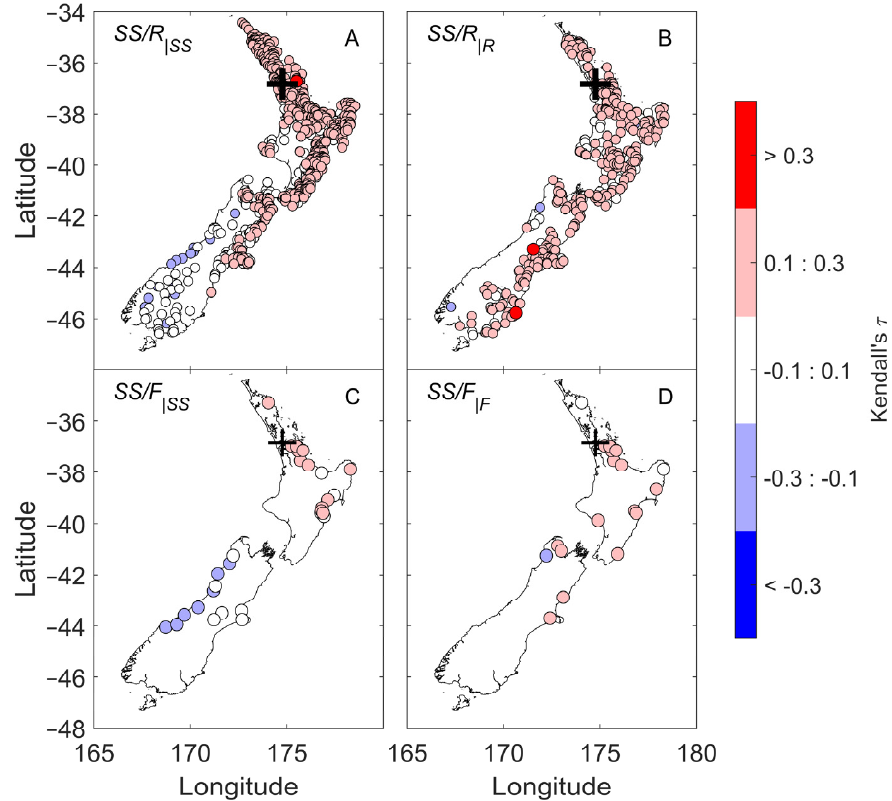
Figure 5. Kendall’s rank correlation coefficient τ (color scale) calculated between skew-surge mea- sured at Auckland and individual rainfall and river-flow records. ( A ) τ for skew-surge and rainfall, with rainfall conditional on extreme skew-surge; ( B ) τ for skew-surge and rainfall, with skew-surge conditional on extreme rainfall, ( C ) τ for skew-surge and river-flow, with river-flow conditional on extreme skew-surge, ( D ) τ for skew-surge and river-flow, with skew-surge conditional on ex- treme